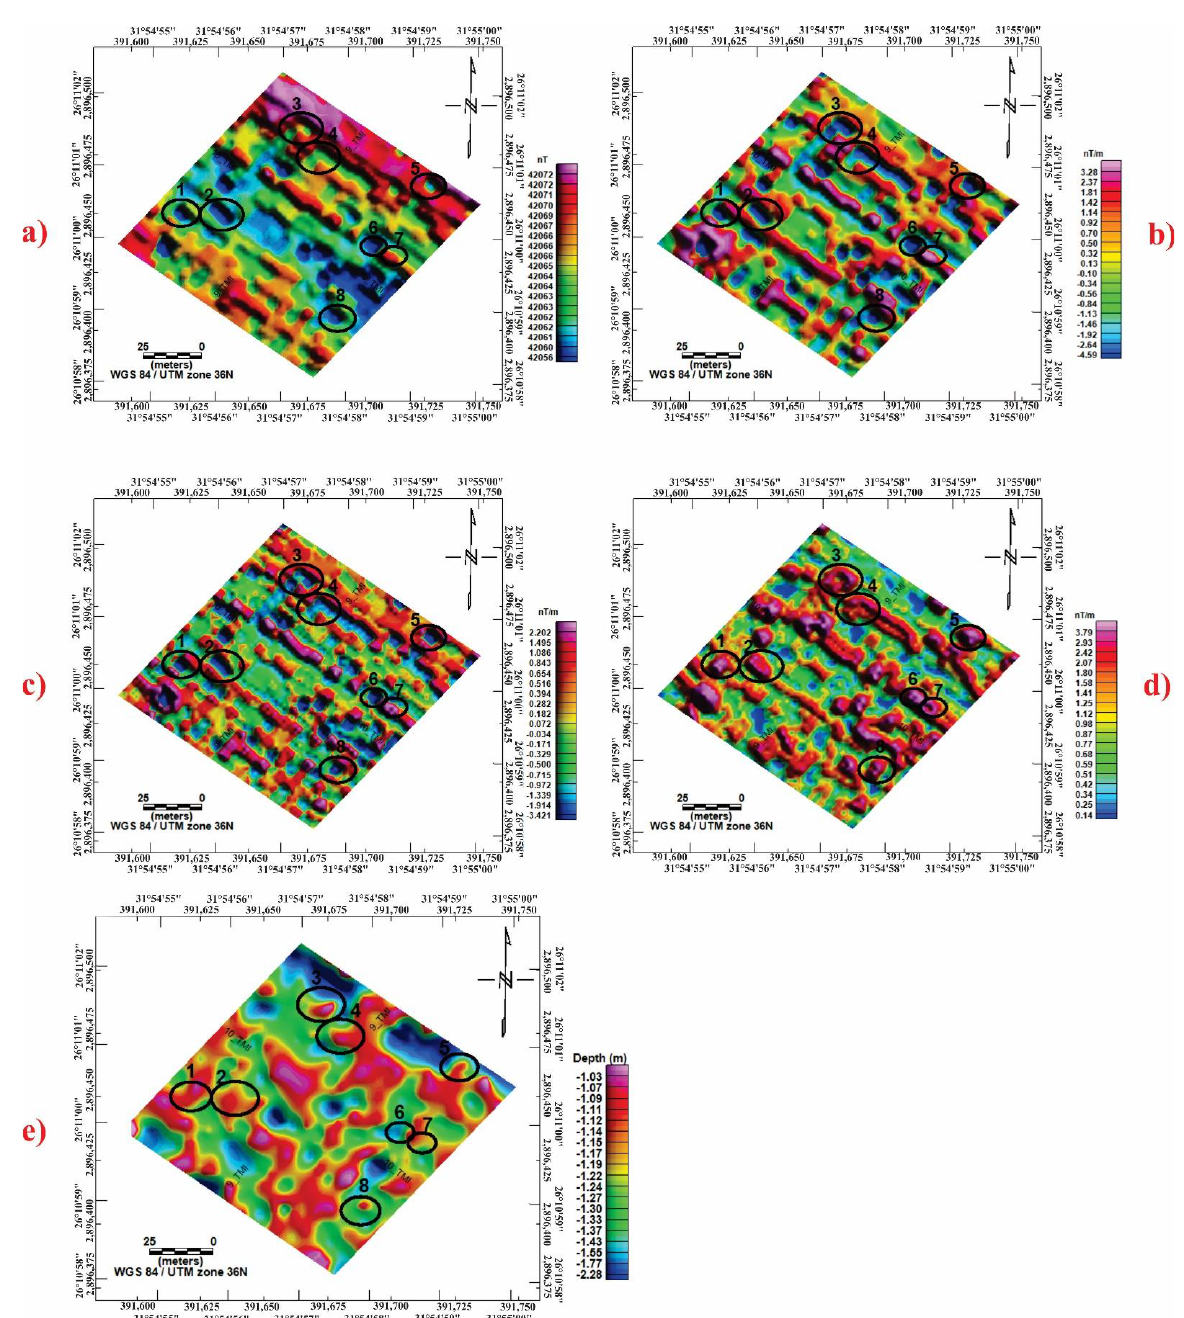
Figure 6. Shaded color relief maps of: ( a ) the total magnetic intensity (TMI), ( b ) the high-pass filter, ( c ) the first vertical derivative (FVD) filter, ( d ) the analytical signal (AS) filter, and ( e ) the source parameter imaging (SPI) technique. The magnetic anomalies that may be archaeological objects are shown by the black circles (1–8), which were validated using the GPR